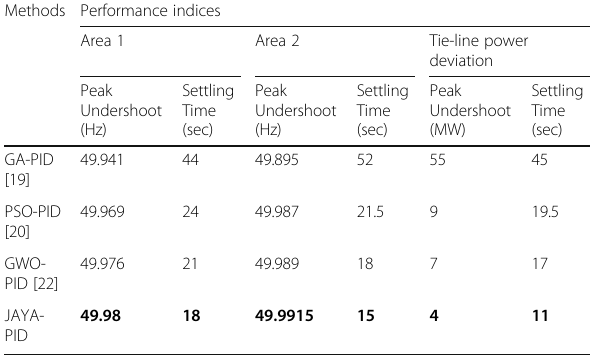
Table 3 Dynamic response of various controllers for scenario 2 instead of optimized PID parameters with different approaches Methods Performance